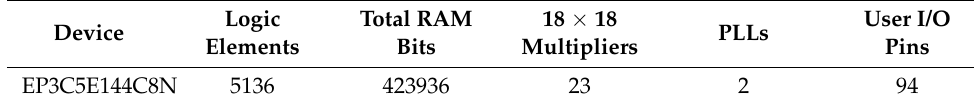
Table 5. EP3C5E144C8N